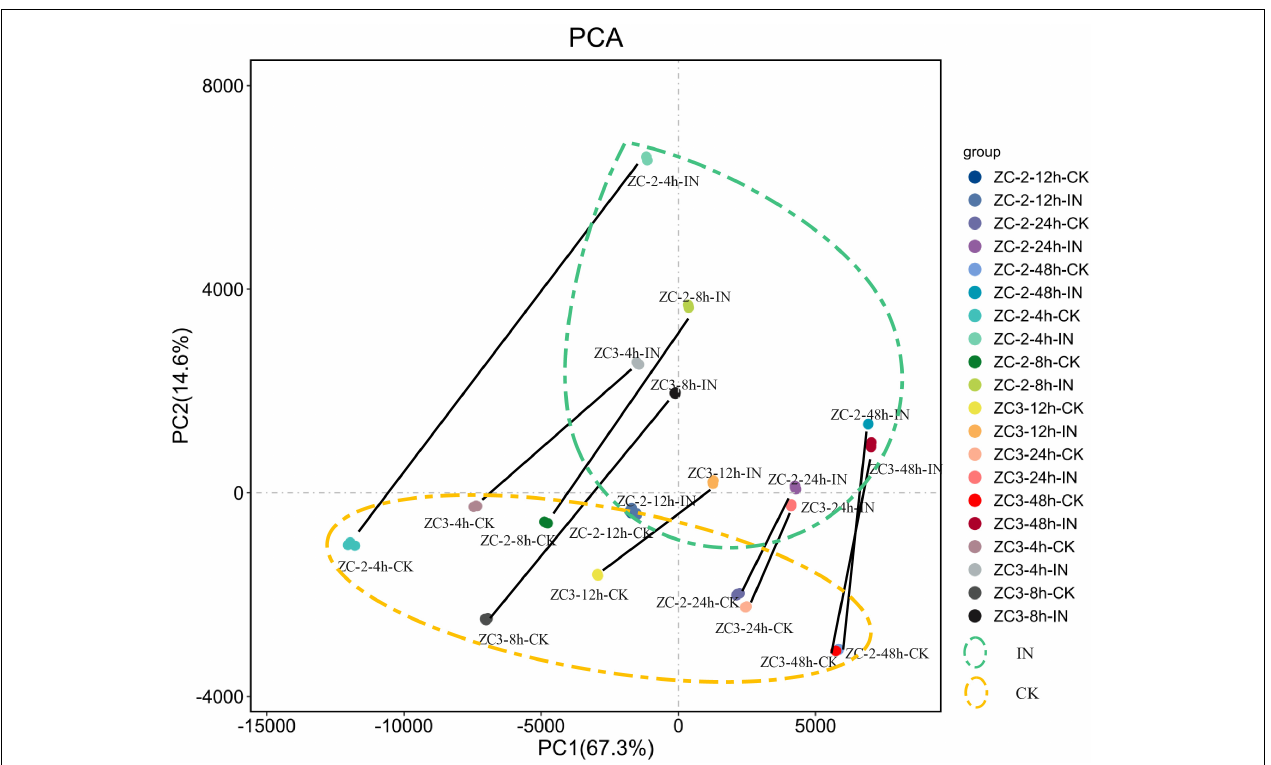
FIGURE 2 | Principal component analysis scatterplot of the first and second principal components (PC1 and PC2, respectively) for gene transcripts detected from pods of soybean lines ZC-2 and ZC3 infected with Colletotrichum truncatum and from non-infected controls (CK) at five time points [4, 8, 12, 24, and 48 h post-inoculation (HPI)] after inoculation. Each sample comprised three biological replicates. All inoculated samples are enclosed by a green dashed ellipse and all control samples are enclosed by an orange dashed ellipse. Each control sample and its corresponding inoculated sample are connected by a black